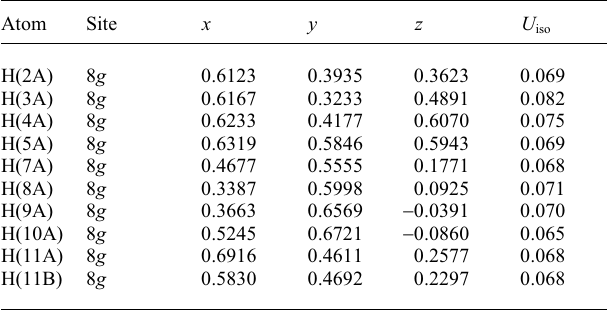
Table 2. Atomic coordinates and displacement parameters (in Å 2 ) .